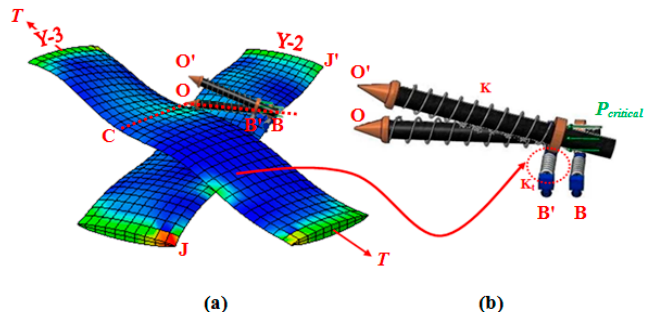
Figure 8. ( a ) The effect of interlacing yarn on wrinkle formation; ( b ) equivalent torsional spring K t , mimicking the bending effect of interlacing yarn Y-3 on the out of plane deformation of Y-2 .